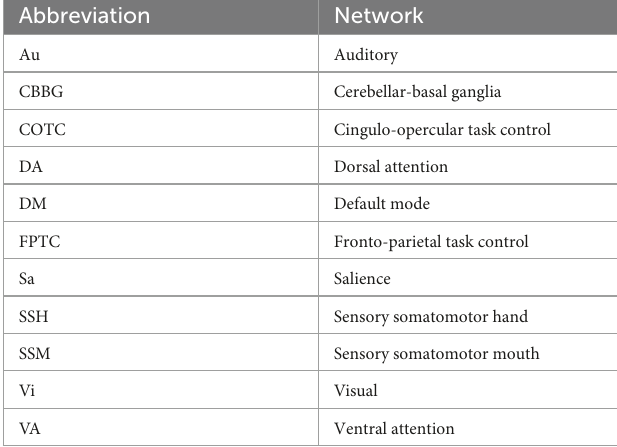
TABLE 1 Network abbreviation